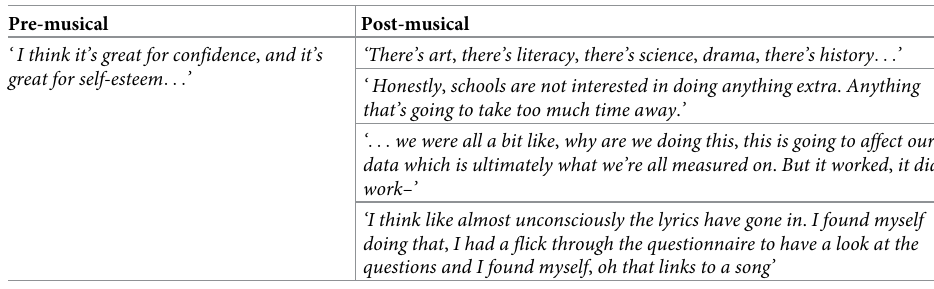
Table 3. Feedback from class teachers pre- and two weeks